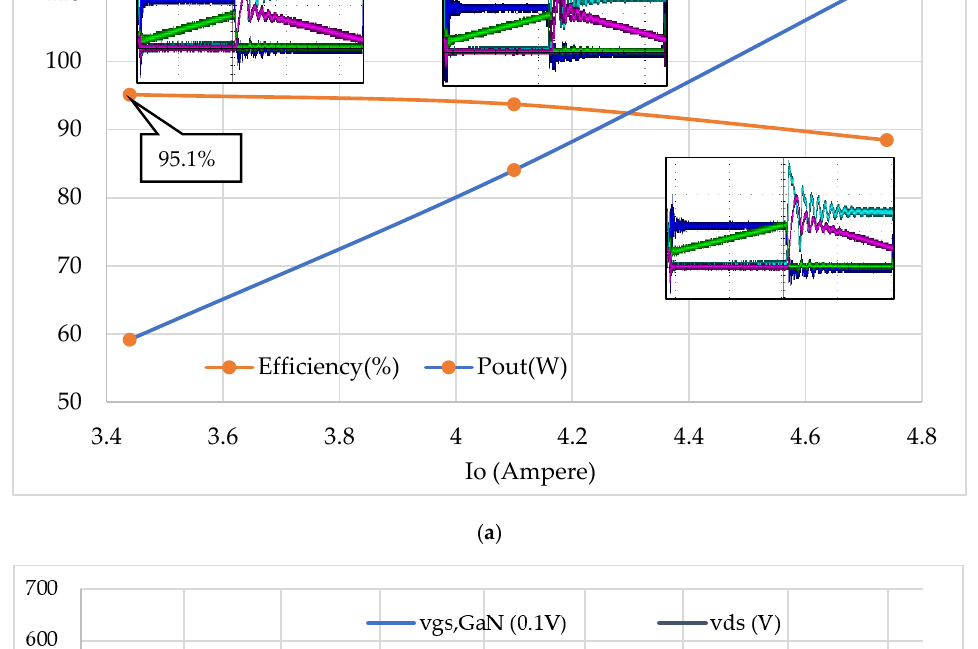
Table 7. Comparison of CCM current.